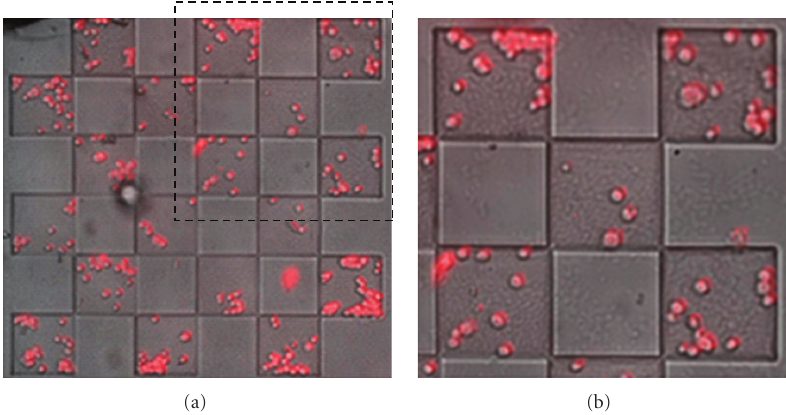
Figure 9: PC12 adhesion on electron-beam-exposed areas